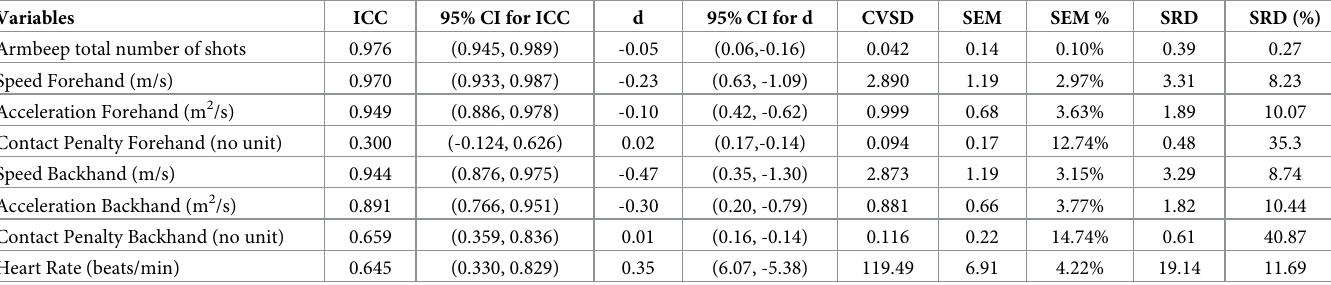
Table 1. Reproducibility parameters for measurements with Armbeep